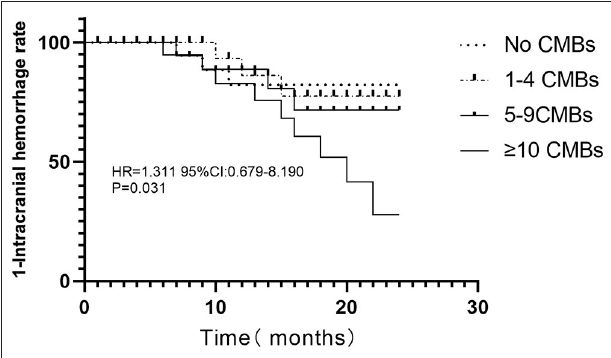
FIGURE 2 | Kaplan–Meier curve for consequent intracerebral bleeding (log-rank test).